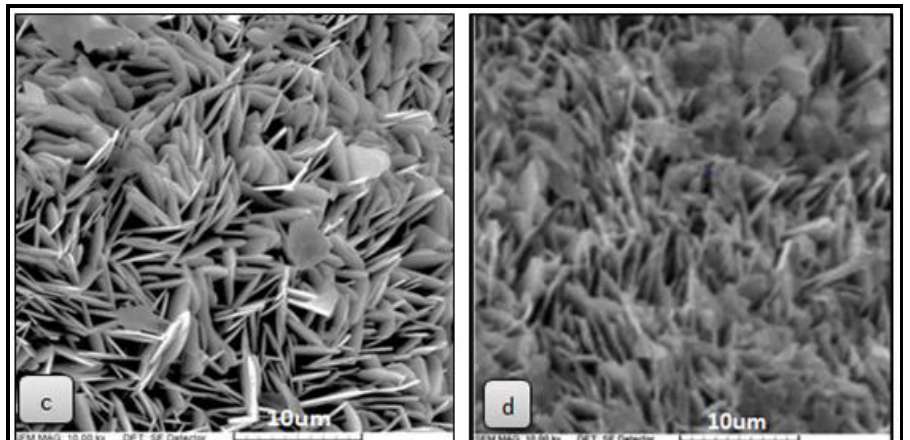
(SEM) image of fractured surface morphology where: (c): for samples with x = 0.1 and y = 0.01, (d): for sample with x = 0.1 and y= 0.02. (At magnification x10000).